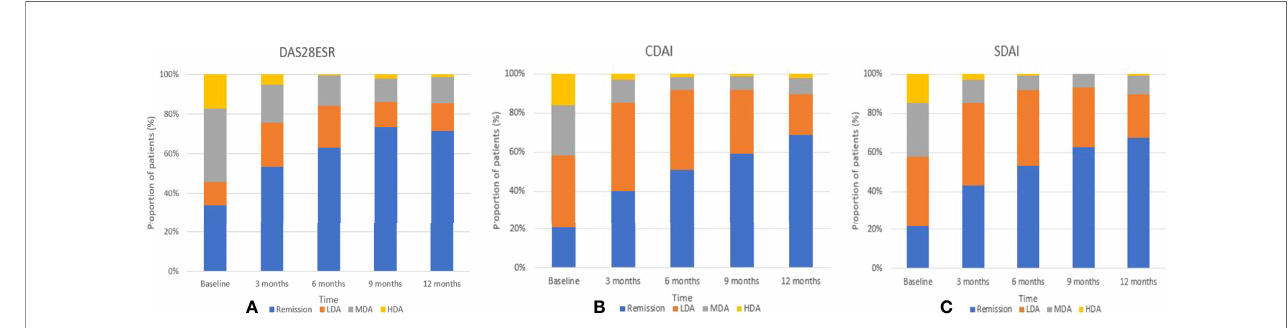
FIGURE 2 | Trends in the percentage of remission, low, moderate, and high disease activity over the fi rst years by DAS28 (A) CDAI (B) and SDAI (C) .